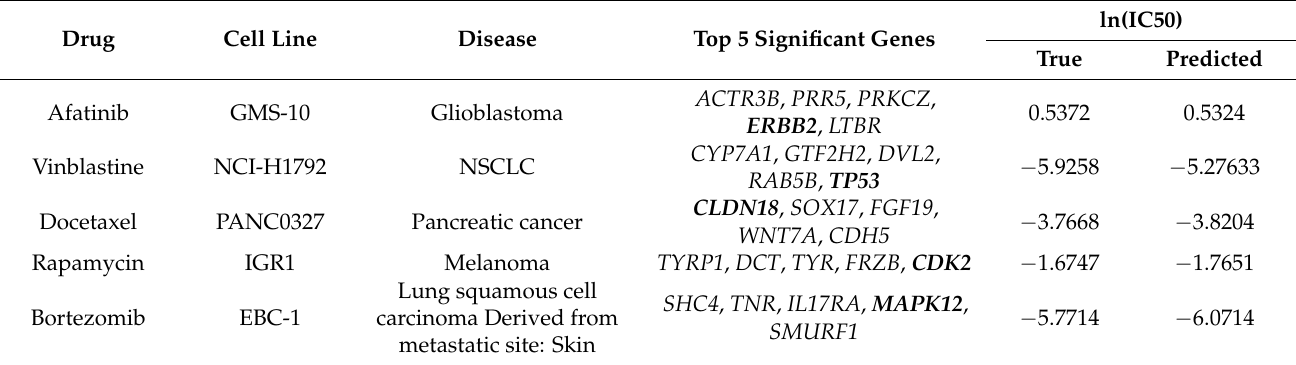
Table 4. Gradient-based gene importance